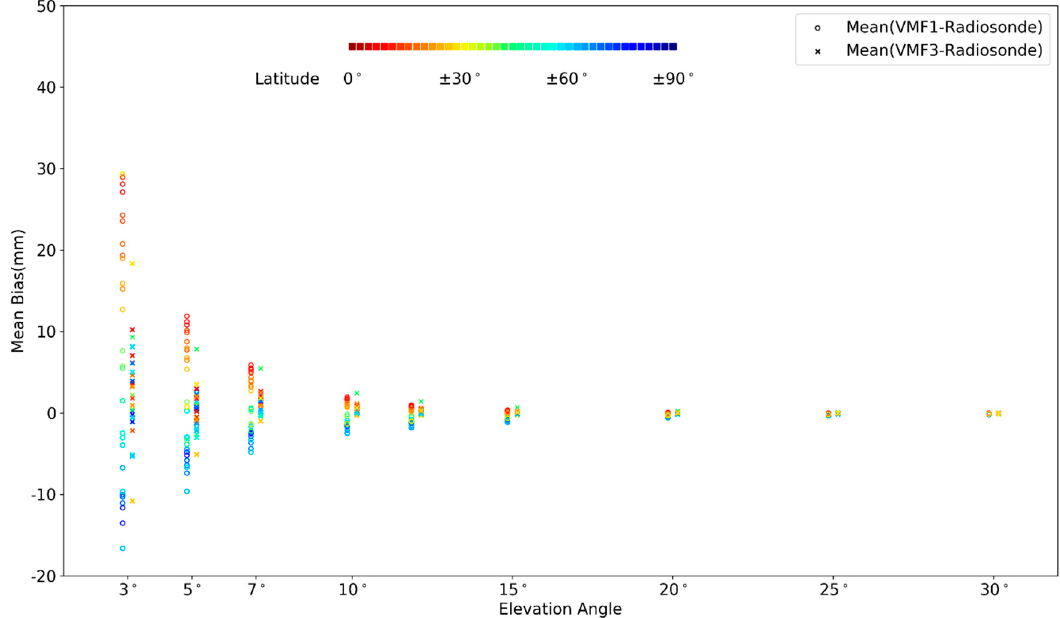
Figure 8. Mean biases between the VMF1/VMF3 SHD estimates with respect to radiosonde + ISA76 SHD estimates by ray-tracing in mm, for the 28 stations of this study, over a 3-year period (1 January 2016 to 31 December 2018). Circle marks stand for the VMF1 case, and cross marks stand for the VMF3 case (the two cases are plotted with a small horizontal shift to avoid overlapping). The color bar indicates the station latitudes.